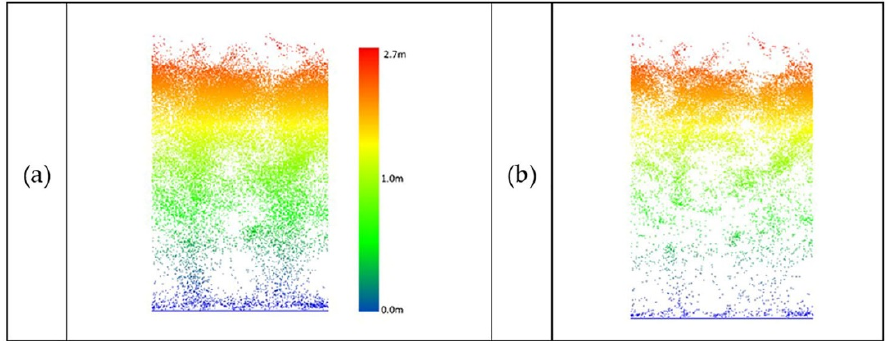
Figure 21. UAV-2 LiDAR data of sorghum (DAS:68). ( a ) Original data, ( b ) outlier removal using PointCleanNet.